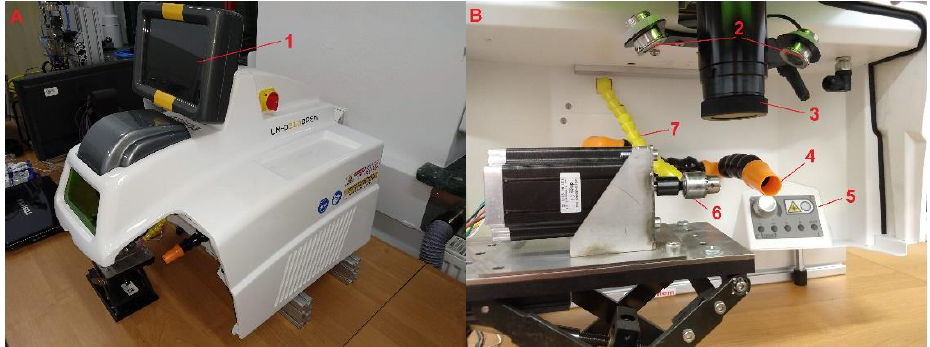
Figure 3. View of the SISMA LM-D210 laser bench. ( A ) — general view, ( B ) — workspace view. 1 — front touch panel, 2 — lighting spots, 3 — laser head, 4 — gas extractor, 5 — manual parameter set panel, 6 — rotary motor, 7 — nozzle of gas shield.